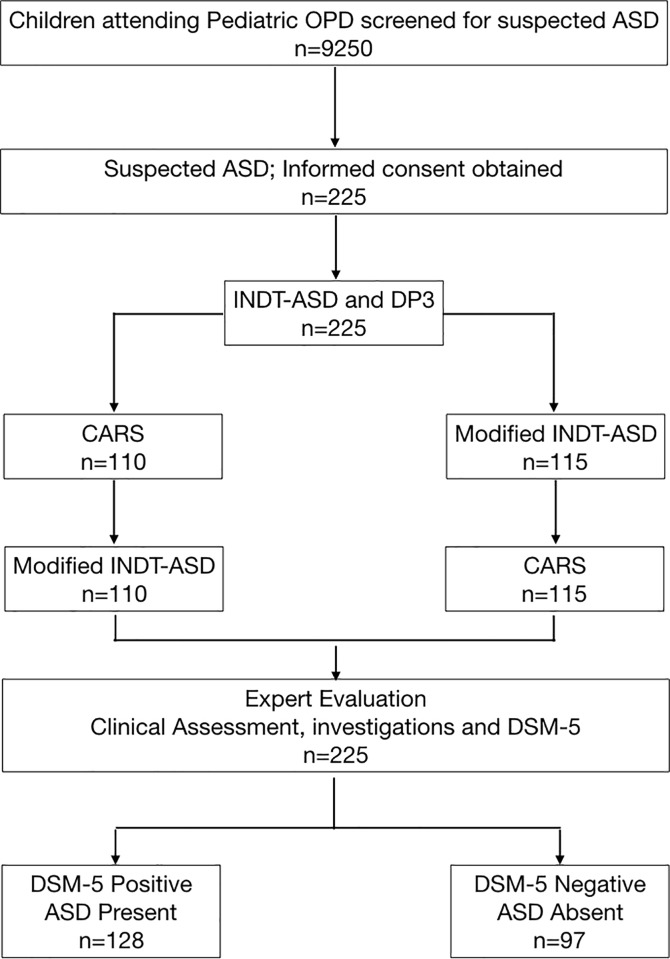
Flow of patients.